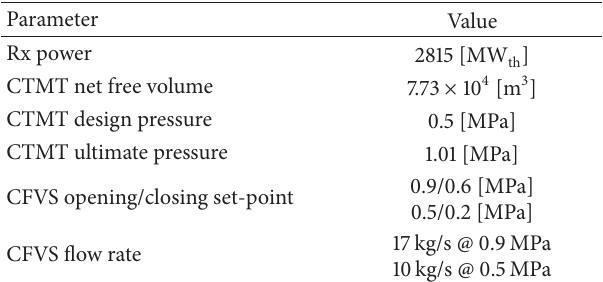
Table 2: Initial and boundary conditions.